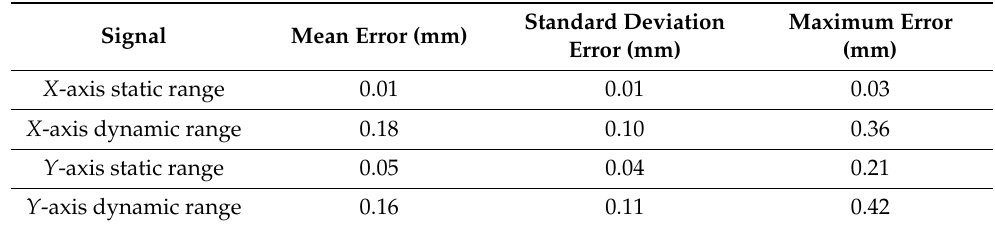
Table 1. Means errors, standard deviation errors, and maximum errors for measured displacement signals during the lab-scale experiments.